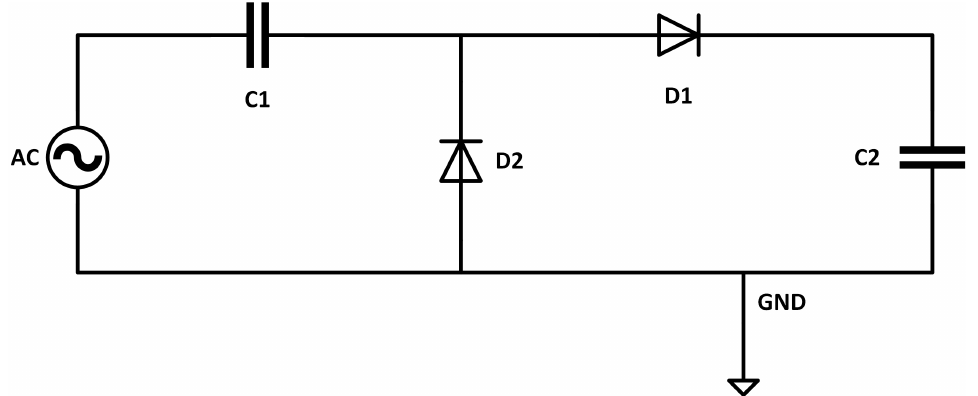
Figure 3. Greinacher topology.